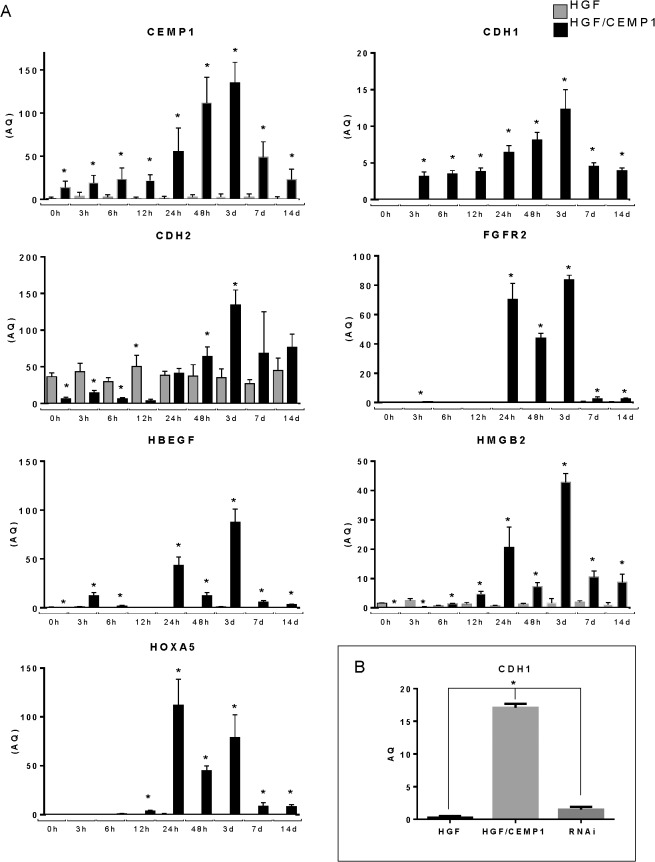
Time series expression pattern of key genes.
Expression of CDH1 before and after RNAi of CEMP1. Expression patterns of the key genes were obtained in an independent time series experiment at 3, 6, 12, 24, 48, hours and 3, 7 and 14 days. The major expression changes as a result of CEMP1 overexpression initiated 24hrs (A). The relationship between CEMP1 and CDH1 was evaluated by RT-qPCR before and after knockdown of CEMP1 expression by RNAi. The RNAi directed against CEMP1 resulted in a significant decrease of CDH1 expression (B).